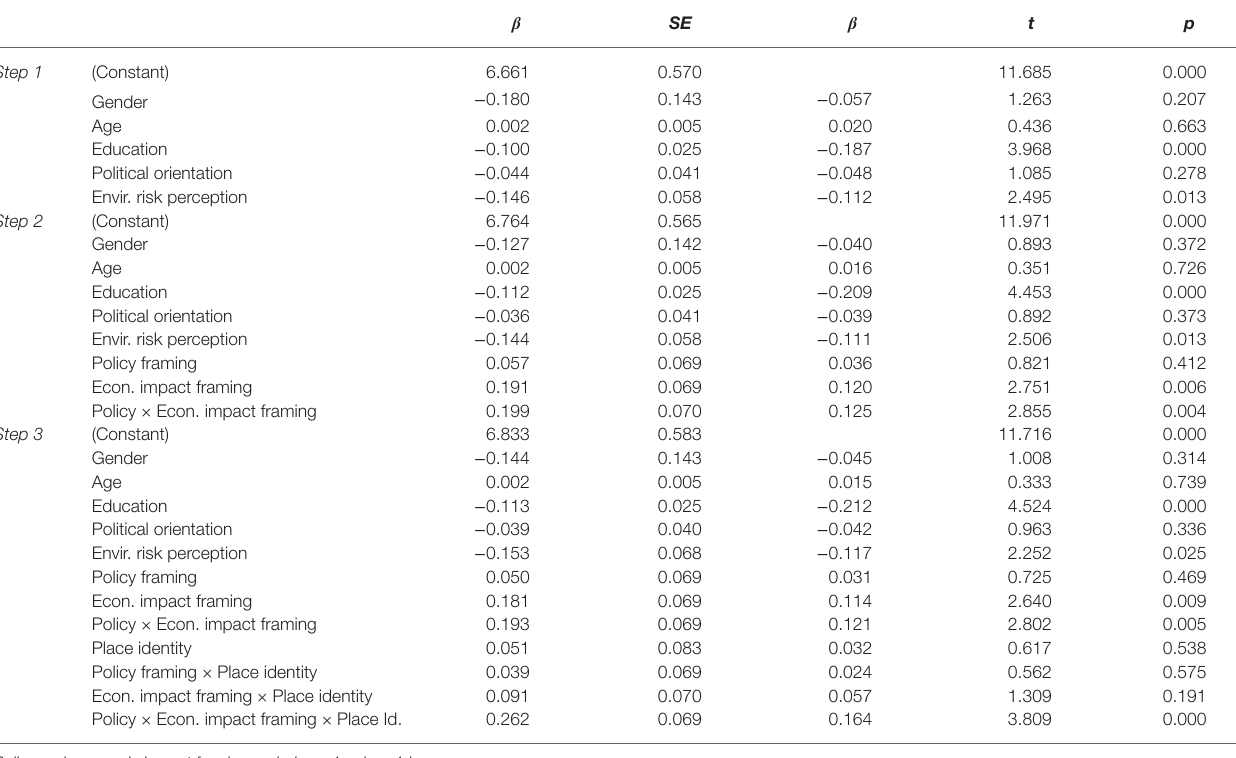
TABLE 5 | Predictors of participants’ agreement with the statement on the economic impact of the policy (Study 2). β SE